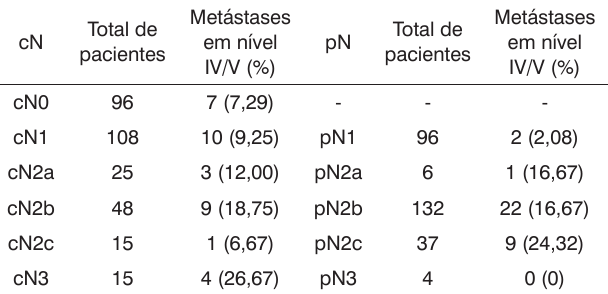
Tabela 3. Distribuição dos pacientes com metástases em nível IV/V em função do estádio patológico do pescoço.